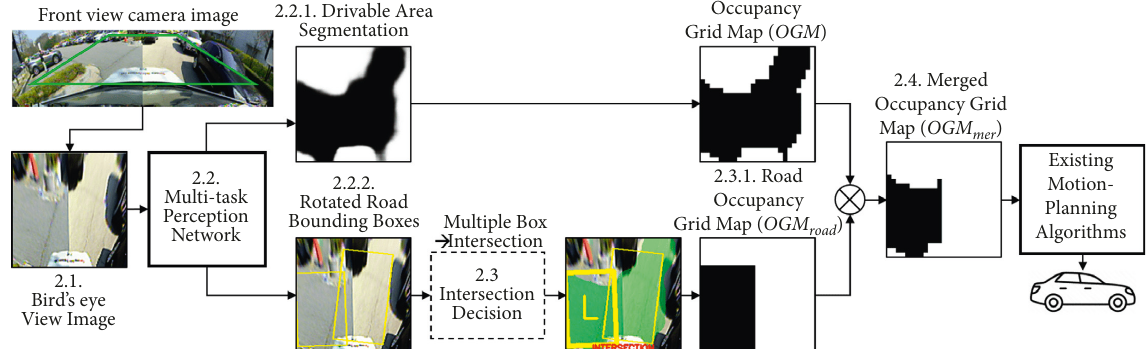
Figure 1: System architecture of vision-based branch road detection and output for navigation.